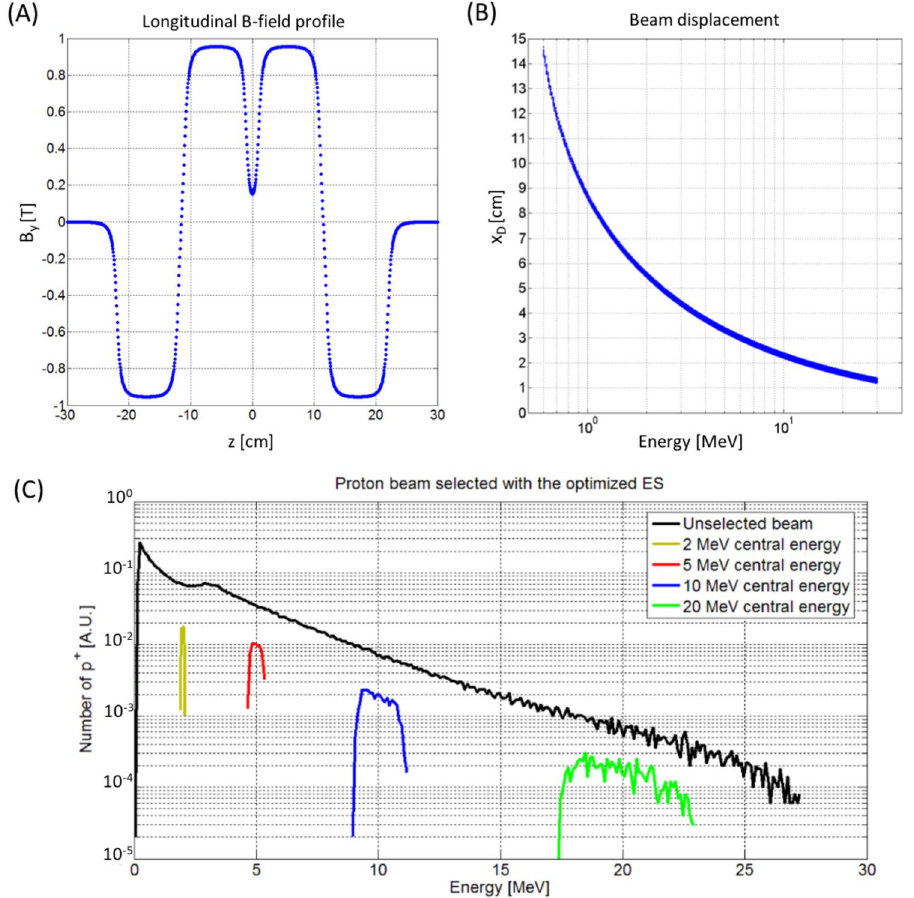
Figure 3. ( A ) B -field profile along the four dipoles of the ES, as a function of the longitudinal axis z. The y maximum value of B reaches ∼ 0.95 T. The profile, which includes fringe fields at the edges of the dipoles, has y been imported into the particle tracking code, in order to run realistic simulations of the ES. ( B ) Displacement of the protons in the x direction, calculated at the longitudinal position where the selecting slit is positioned, i.e. where the beam dispersion is maximum. The displacement is reported as a function of the proton energy. ( C ) Initial (black curve) and final (colored curves) energy spread of the proton beam as obtained with an ES having the parameters reported in Table 1. The selected energies are 2, 5, 10, 20 MeV and the final energy spread is < 20% for all the cases. For this set of simulations, a collimated beam with a divergence of 3 mrad has been used, i.e. the losses induced by the collimating slit at the entrance of the ES are not taken into account, leading to an efficiency of the ES of η ES ≈